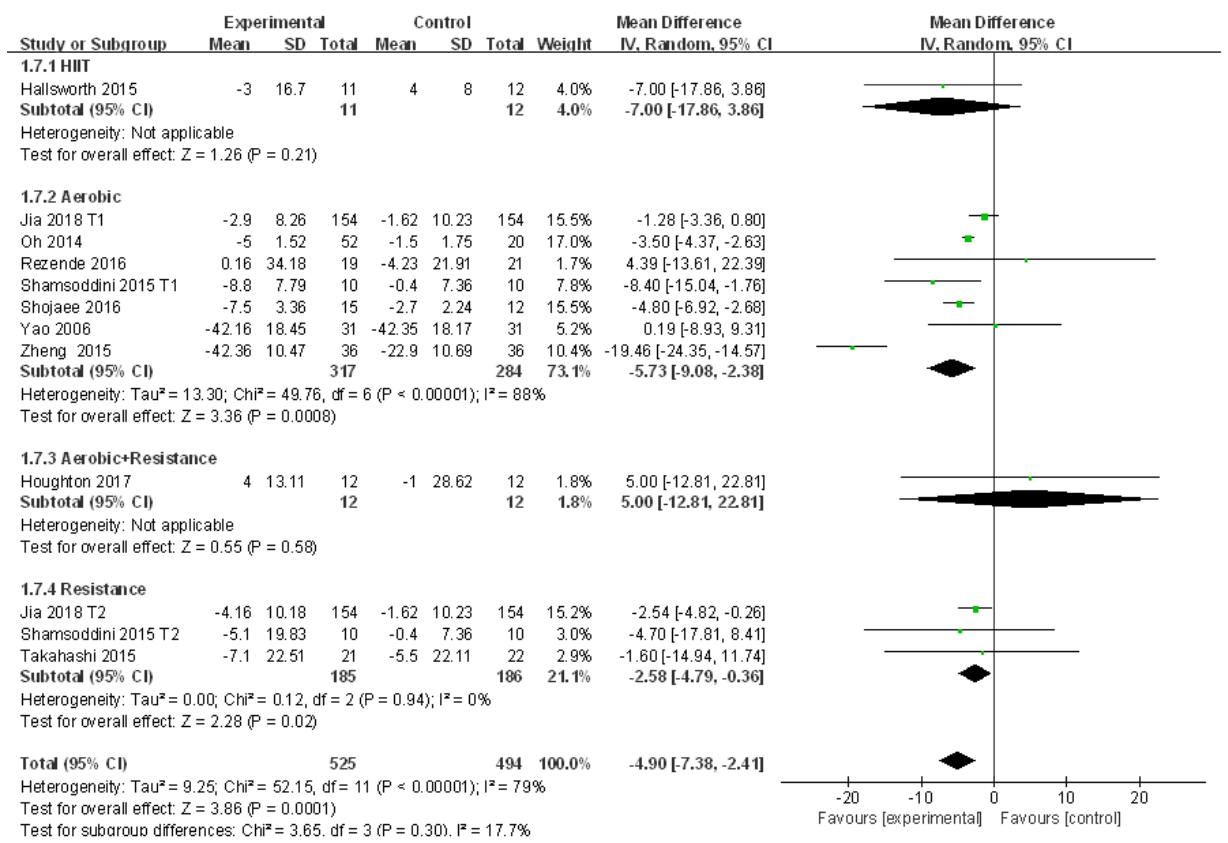
Table 7. Meta regression analysis of heterogeneous factors of AST.